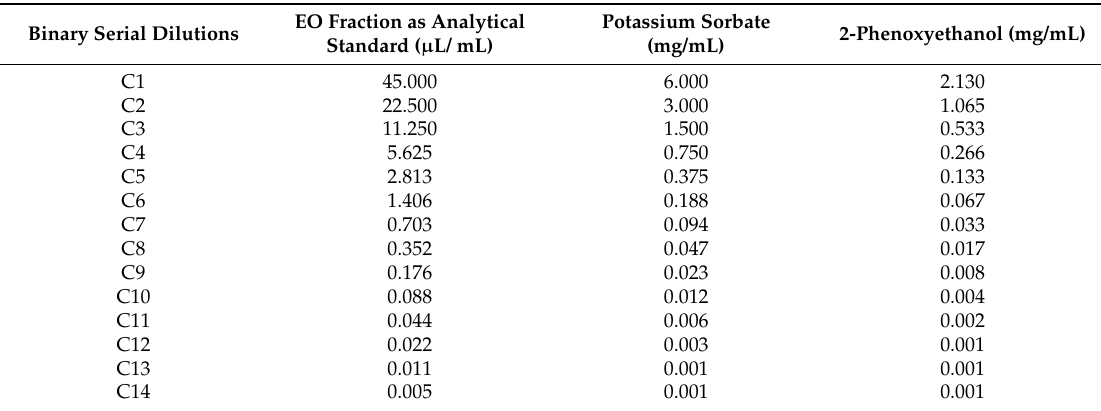
Table 4. The range of binary serial dilutions.